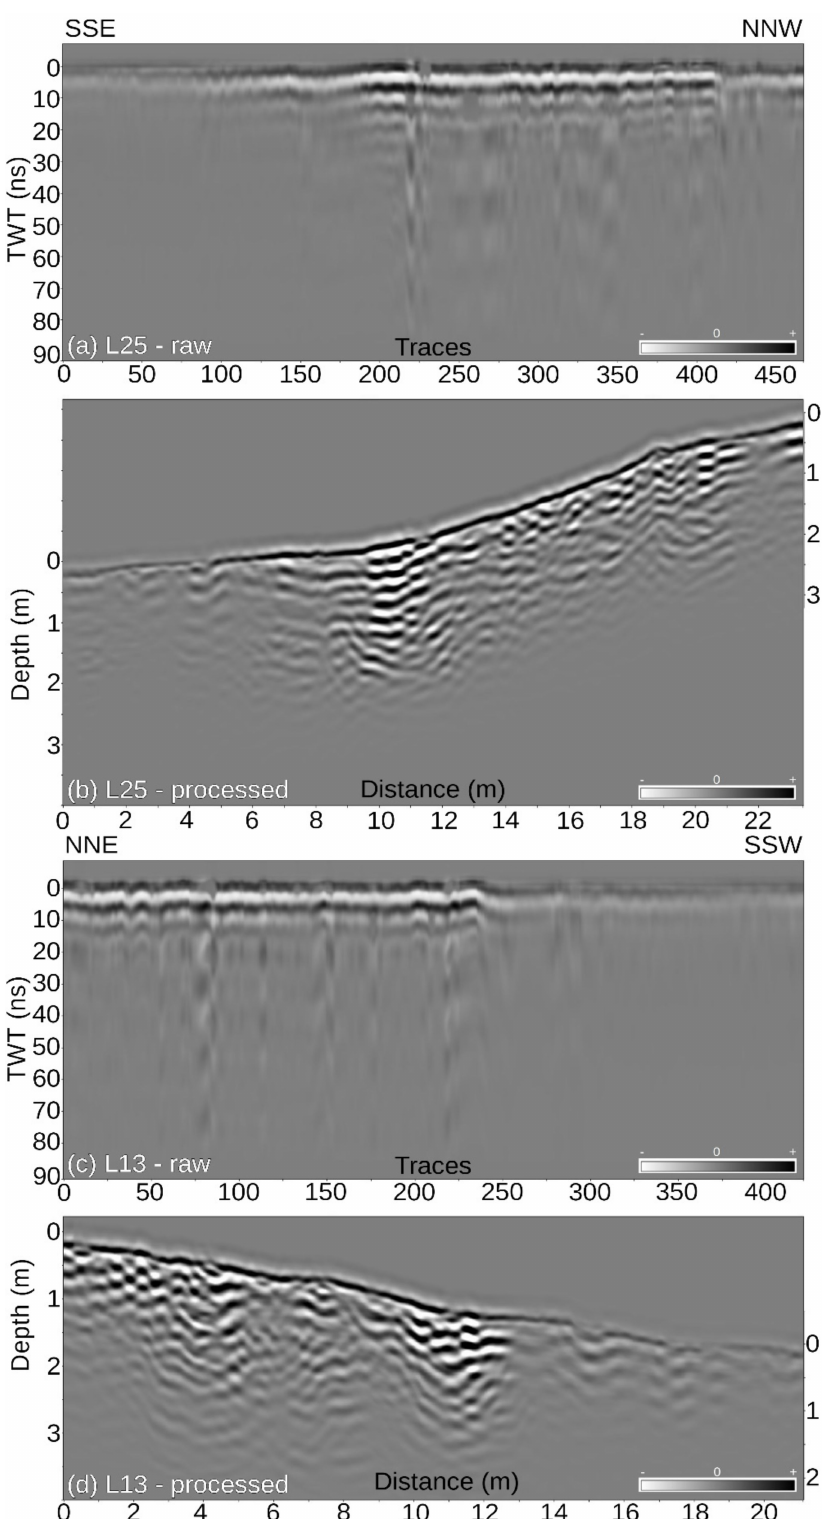
Figure 10. Two examples of GPR profiles recorded using the 300 MHz antenna at the Bargiano study site; ( a ) raw GPR profile L25 crossing the cololite C3 at ~10 m; ( b ) processed GPR profile L25 in which higher reflectivity and deeper penetration are visible across C3, whilst strong attenuation characterize the sector from the base of the slope to the end; ( c ) raw GPR profile L13 not crossing any outcropping cololites ( d ) processed GPR profile L13 showing a shallow, highly reflective body at a 11–12 m distance range; like for profile L25, strong attenuation is also visible in its final sector (distance interval 13–21